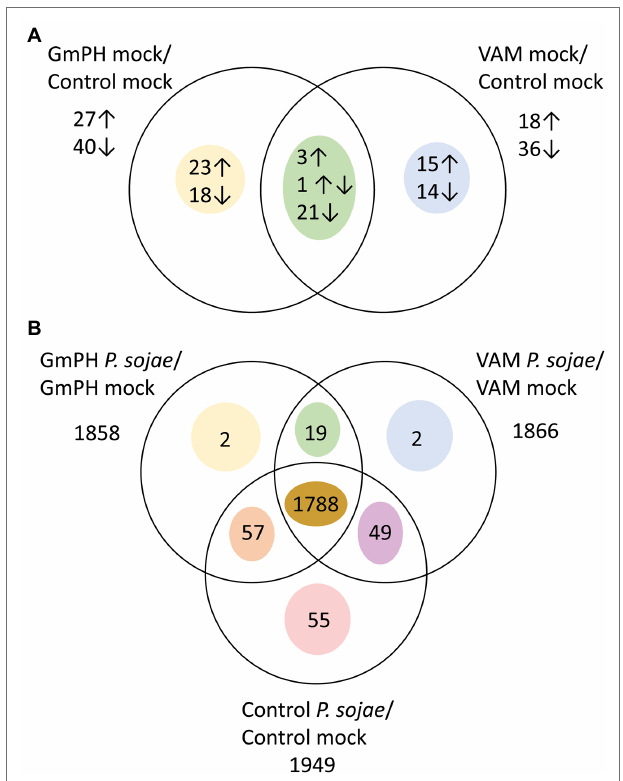
FIGURE 5 | Genes differentially expressed among transgenic lines following mock or P. sojae inoculation. (A) Numbers of genes with transcript levels differing significantly (FDR p < 0.1) and by at least 2-fold comparing GmPH or VAM lines with control lines. Arrows indicate whether transcript levels were higher or lower than the control lines. One gene had higher levels in GmPH lines but lower in the VAM lines. (B) Numbers of genes with transcript levels differing significantly (FDR p < 0.1) and by at least 2-fold comparing P. sojae - with mock-inoculated tissue.